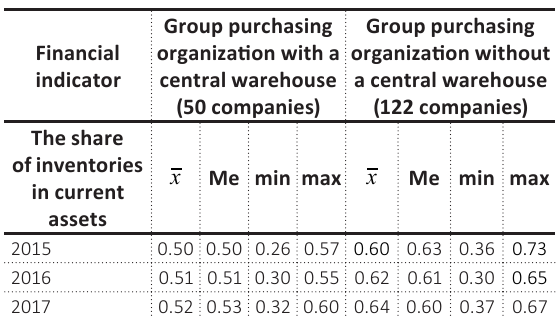
Table 1. Average share of inventories